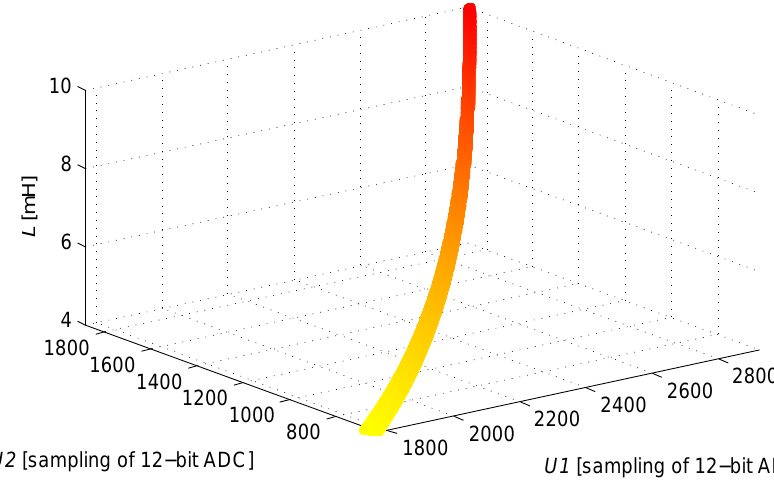
Figure 13. The solution of function L ( U 1 , U 2 ) .